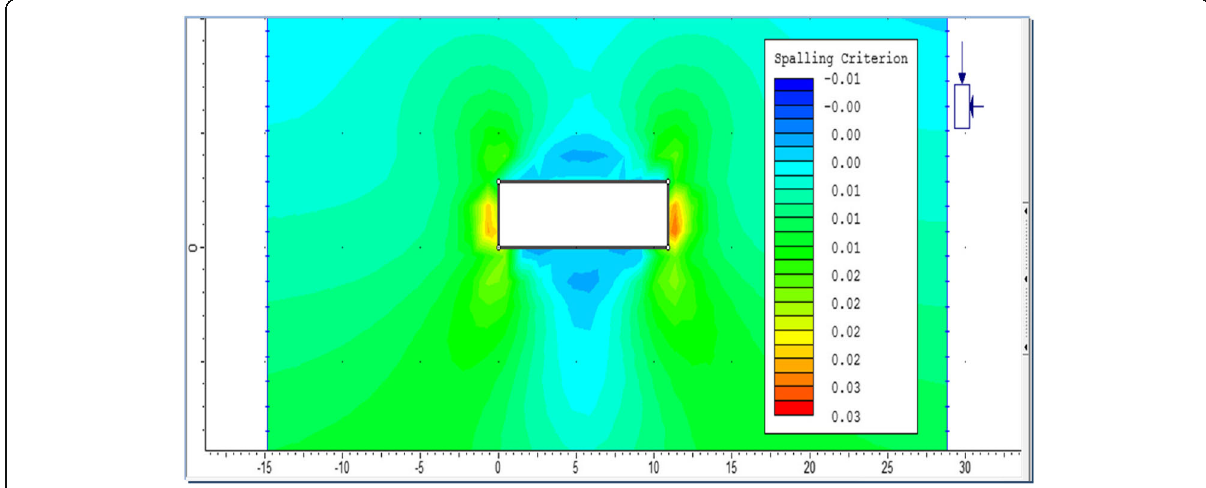
Fig. 18 Spalling Criterion for the ceiling and sidewalls of northern Chamber. Examine